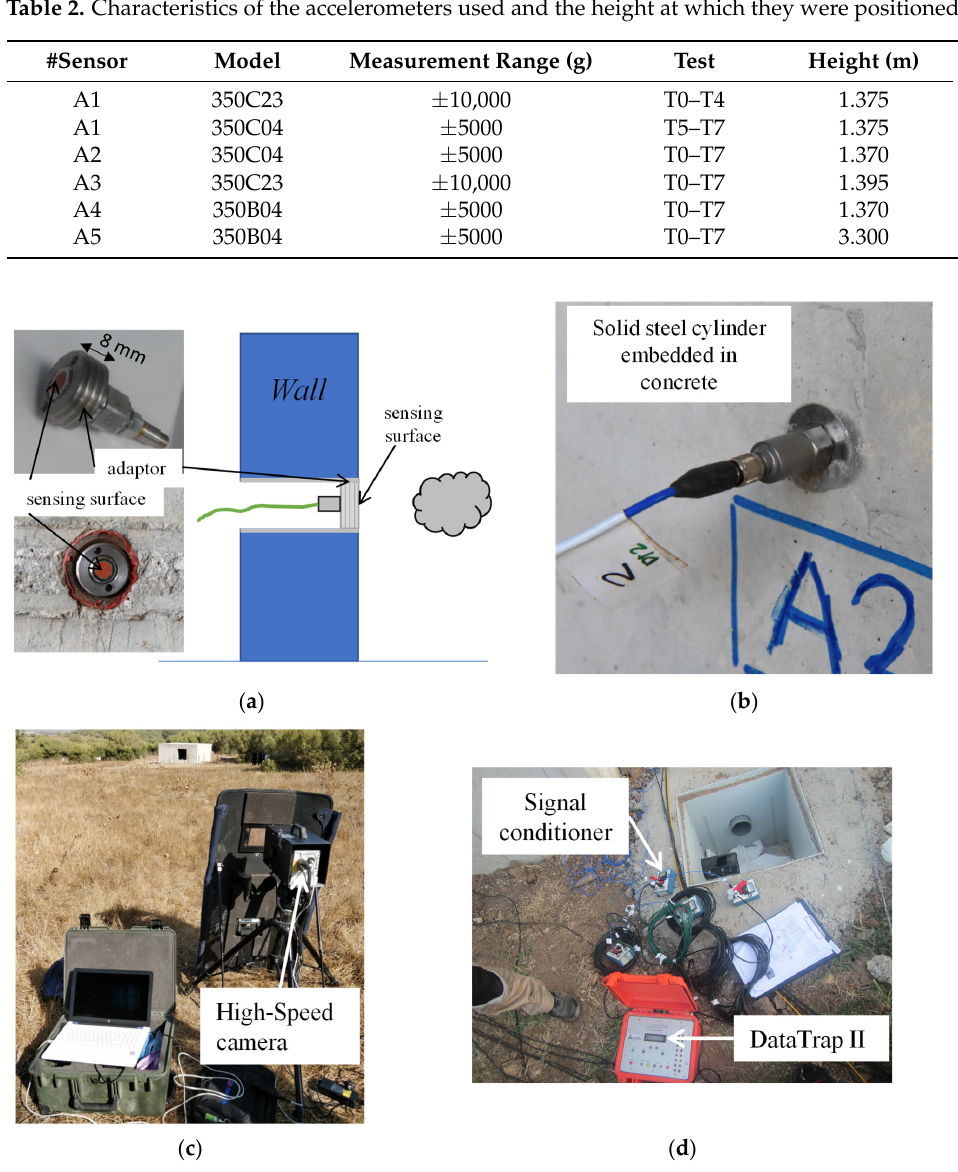
Figure 2. ( a ) Pressure sensors (PCB 102B), details of the P1. ( b ) Accelerometer in position A2. ( c ) Location of the high-speed camera in one of the tests. ( d ) Signal conditioners and DataTrap II recording Table 2. Characteristics of the accelerometers used and the height at which they were positioned.